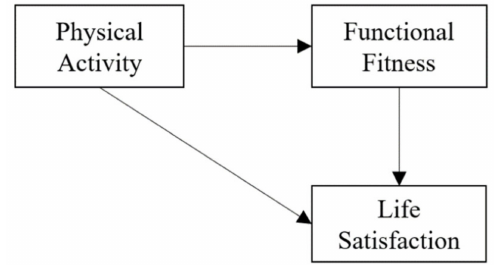
Figure 1. The conceptual model of this